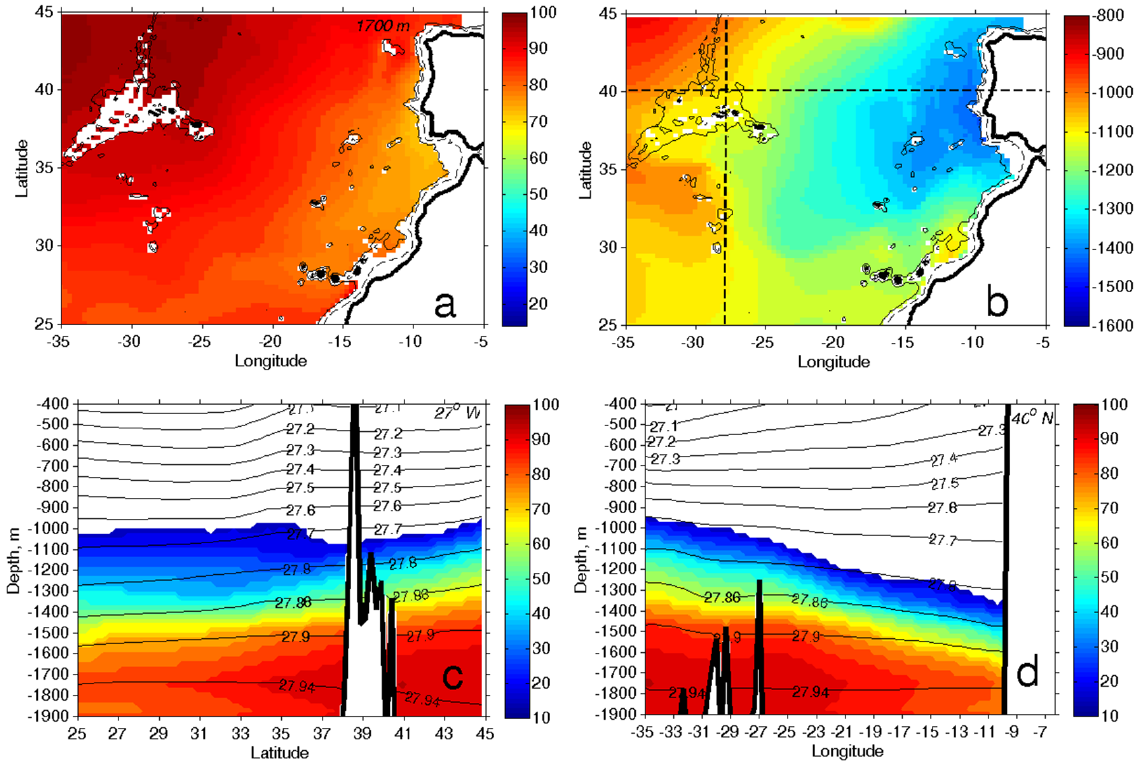
Figure 9. LSW and NADW u : (a) LSW + NADW u content (%) at 1700m; (b) depth of 25% of LSW + NADW u content. Isobaths of 500 and 2000m are marked in dashed and solid black lines, respectively. Zonal and meridional sections, presented in panels (c) and (d) , are marked with dashed black lines. (c) meridional section of LSW + NADW u content (%) along 27 ◦ W; (d) zonal section of LSW + NADW u (%) along 40 ◦